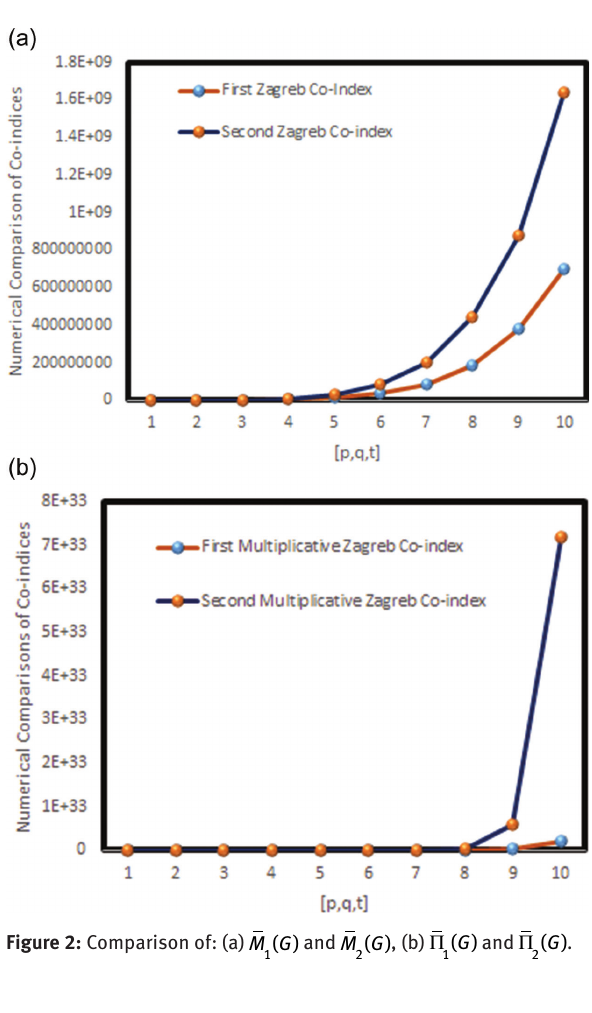
Figure 2: Comparison of: (a) M G ( )